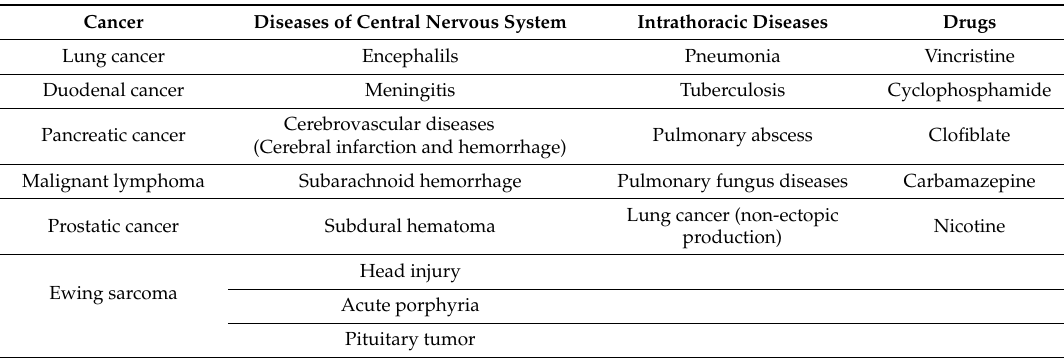
Table 1. Causes of